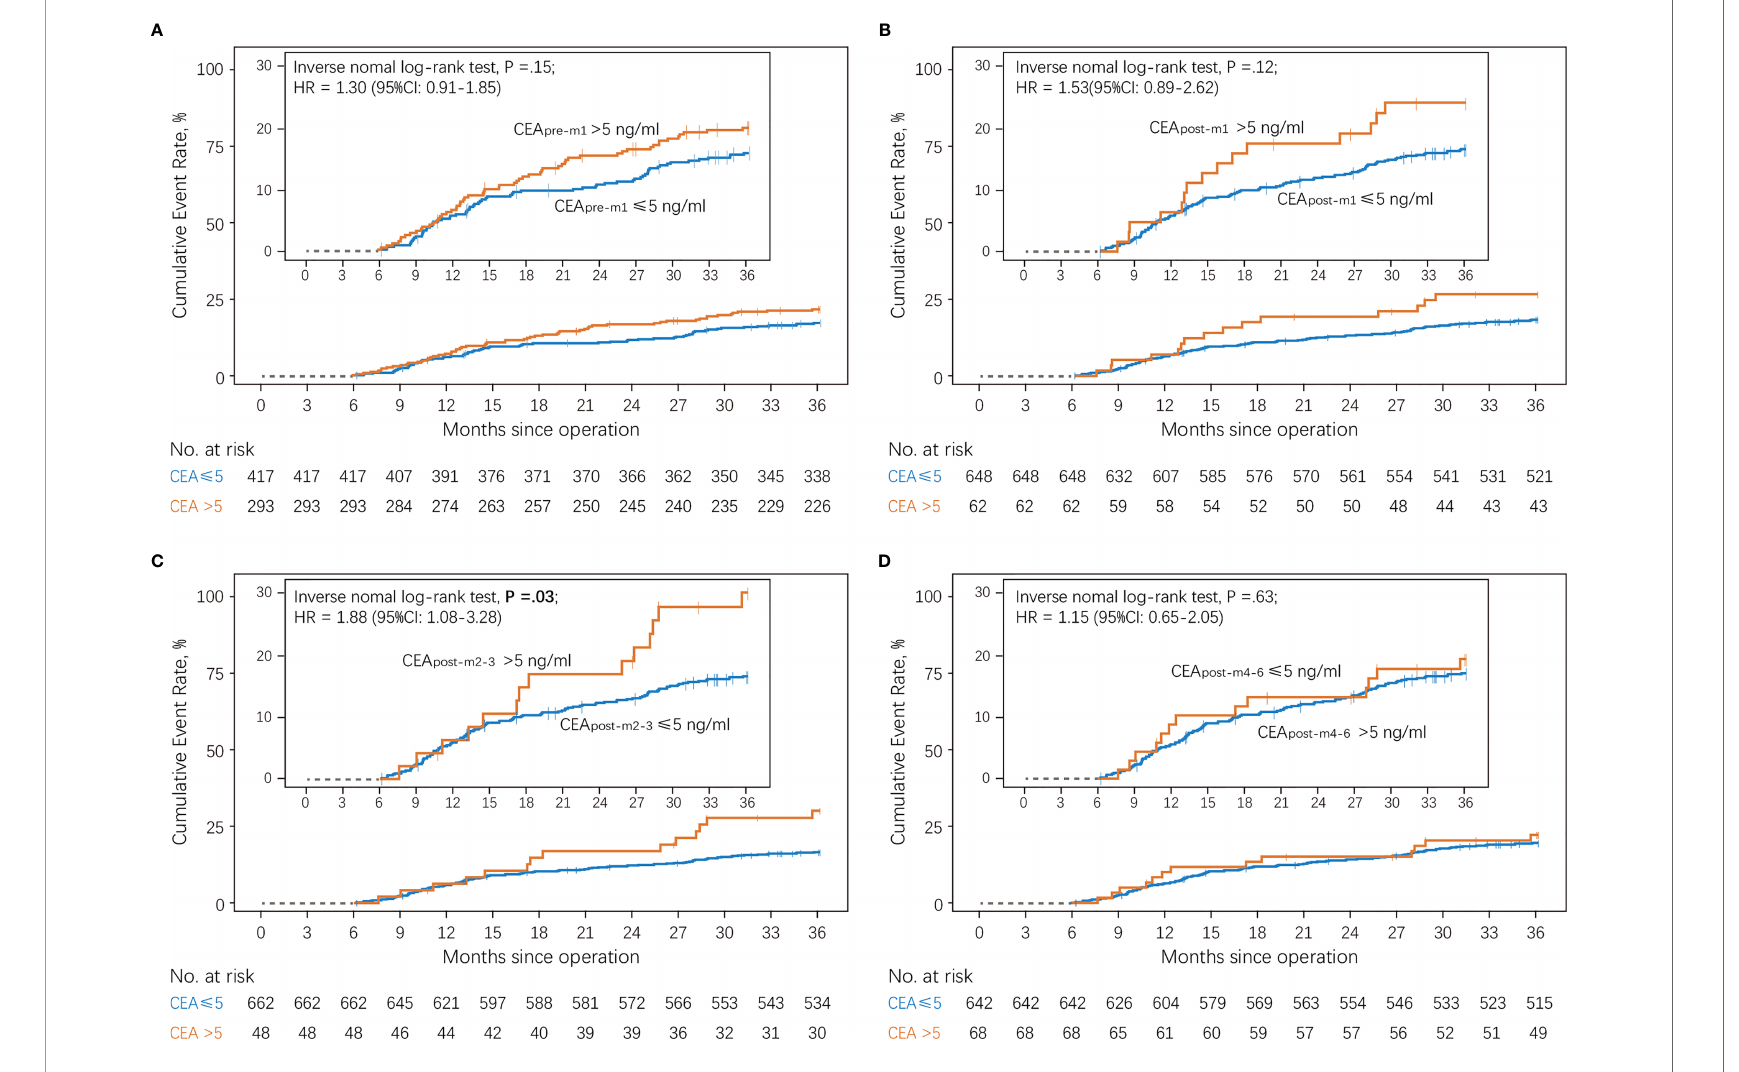
FIGURE 3 | Cumulative incidence of recurrence according to serum CEA levels compared using a log-rank test (A) Patients with normal vs. elevated preoperative CEA levels (CEA pre-m1 ). (B) Patients with normal vs. elevated CEA levels 1 month after surgery (CEA post-m1 ). (C) Patients with normal vs. elevated CEA levels 2 – 3 months after surgery (CEA post-m2 – 3 ). (D) Patients with normal vs. elevated CEA levels 4 – 6 months after surgery (CEA post-m4 – 6 ). CEA, carcinoembryonic